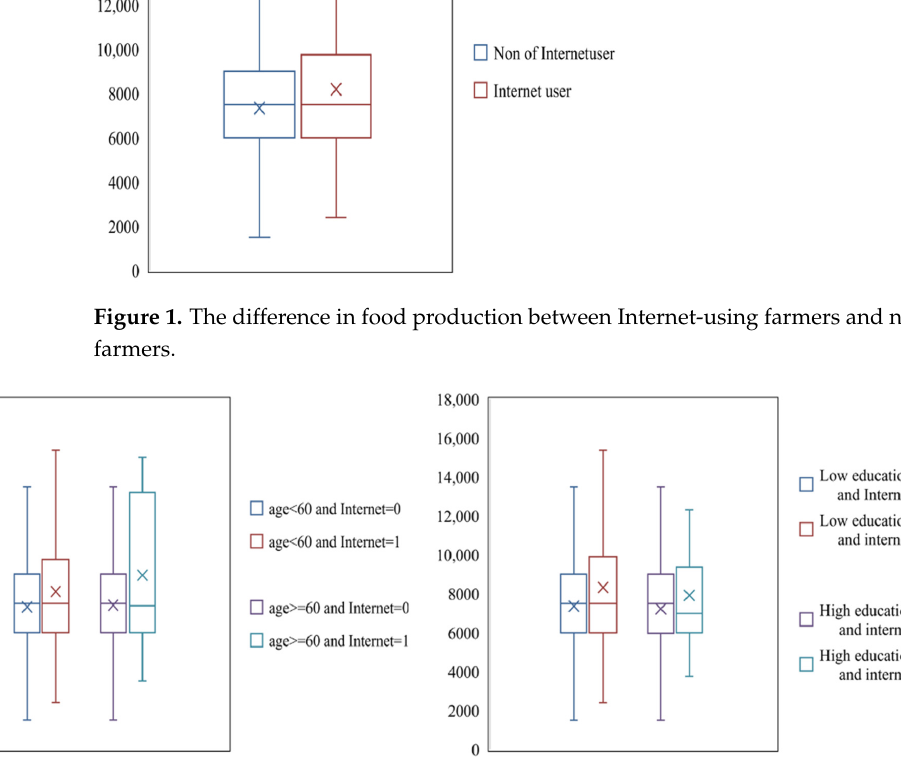
Figure 2. Grain production of Internet-using farmers and non-Internet-using farmers under different age and education levels.